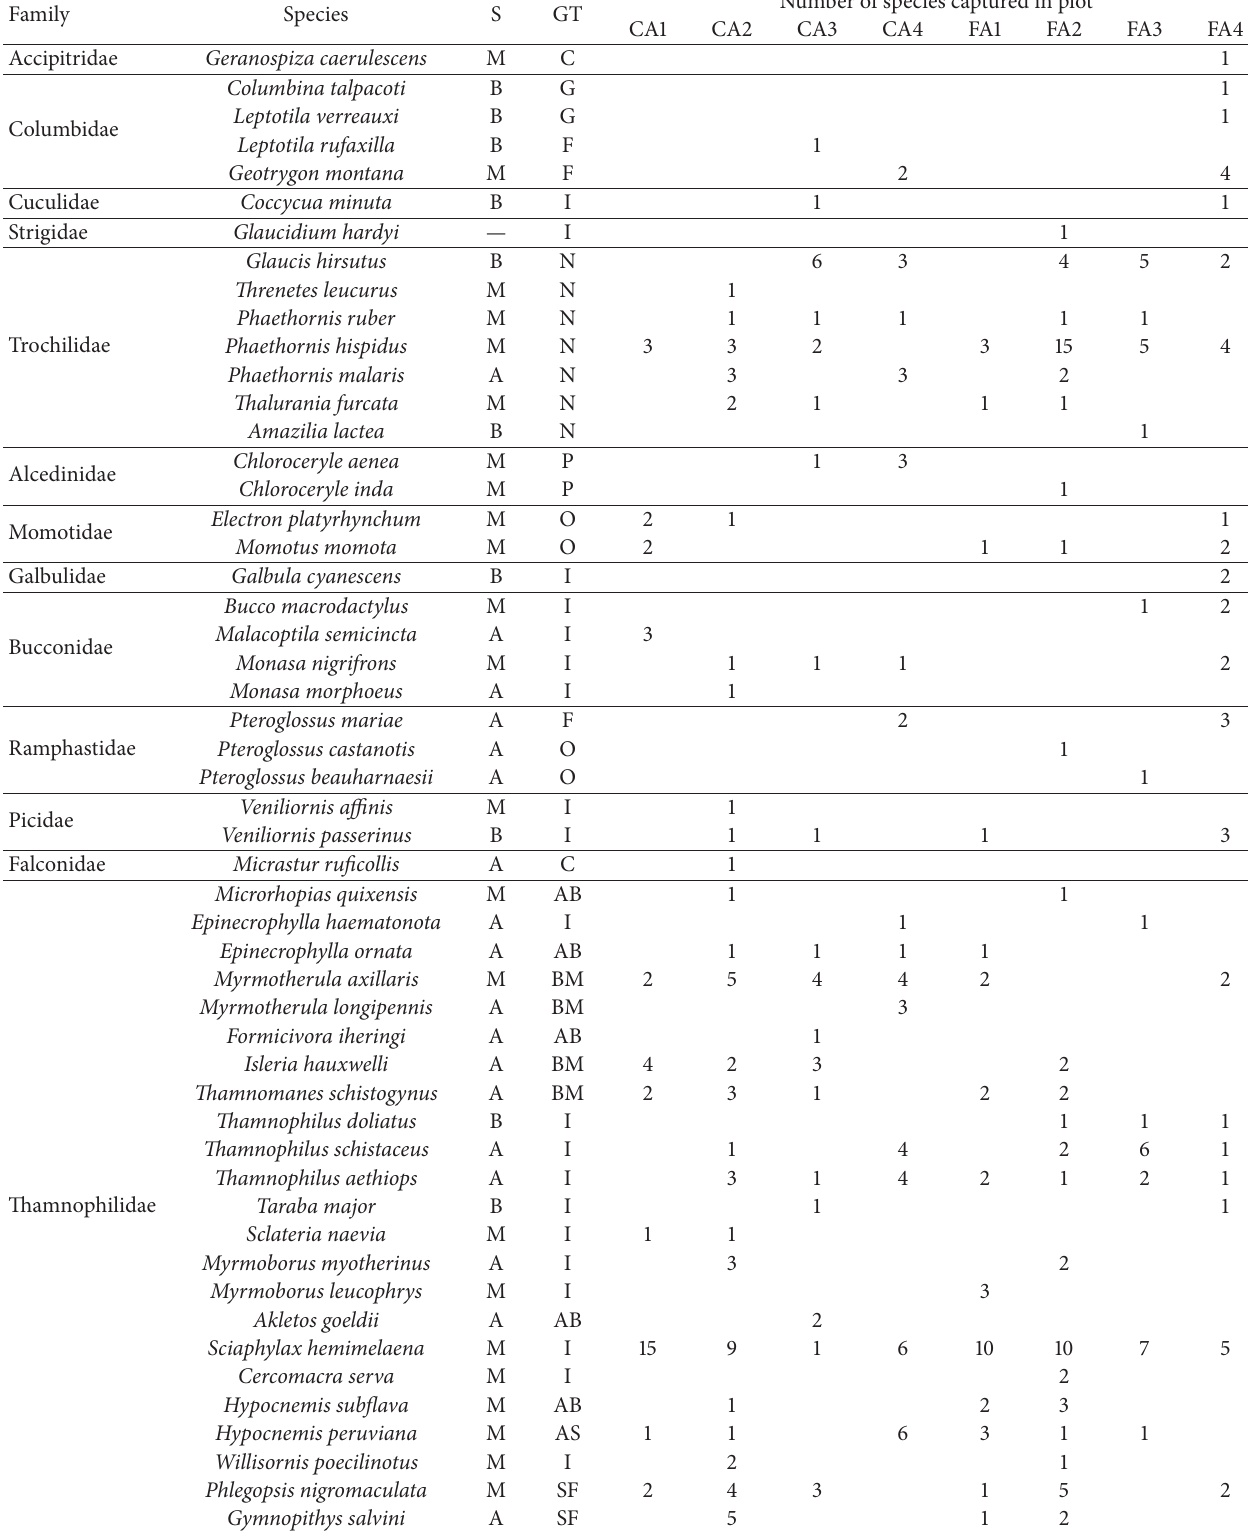
Table 2: Bird species captured during the present study in eastern Acre (Brazil), in burned (AF1–4) and control (AC1–4) plots. S: sensitivity to habitat disturbance (H: high, M: medium, and L: low). TG: trophic guild (IB: insectivore associated with bamboo forest; MF: insectivore associated with mixed flocks; C: carnivore; F: frugivore; G: granivore; I: insectivore; N: nectarivore; O: omnivore; P: piscivore; AB: antbird; SA: solitary arboreal species; CA: species associated with